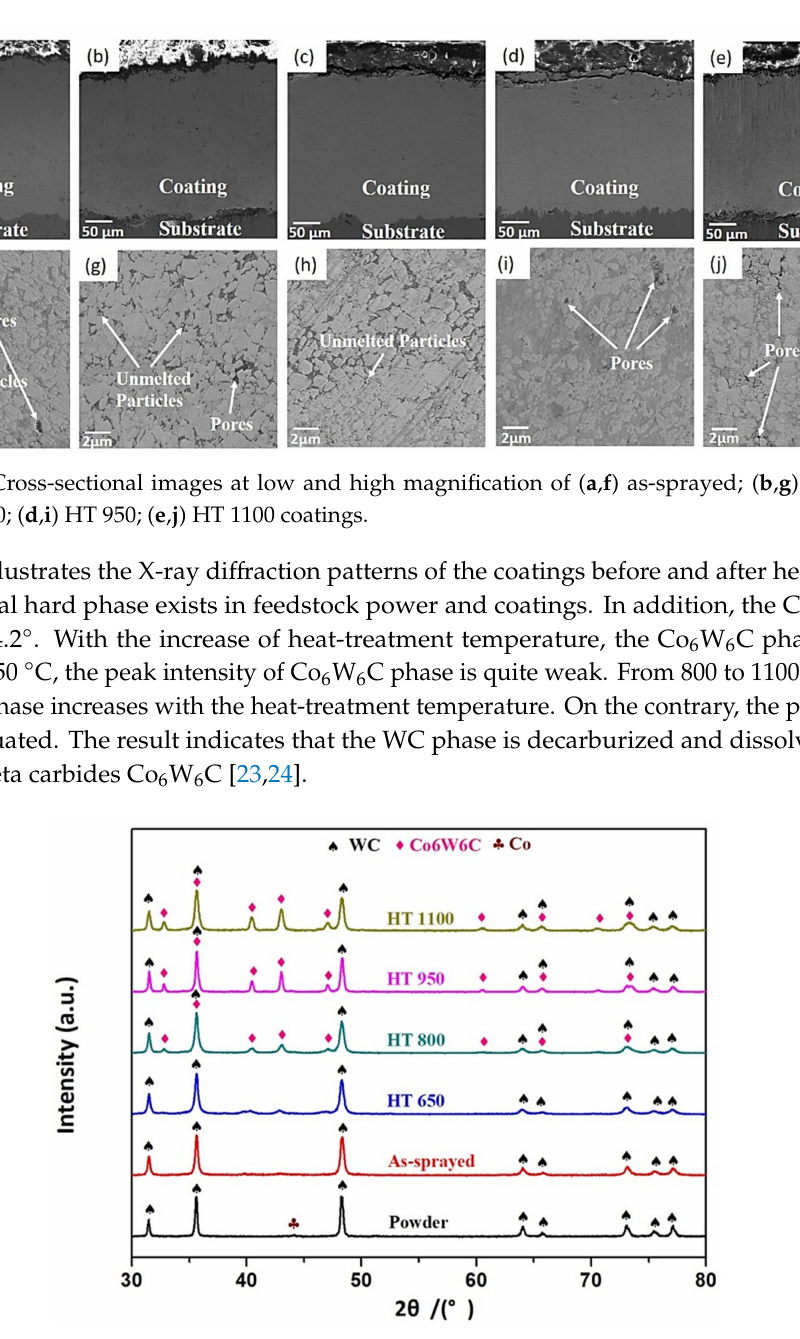
Figure 4. XRD patterns of WC–12Co powder, as-sprayed and heat-treated